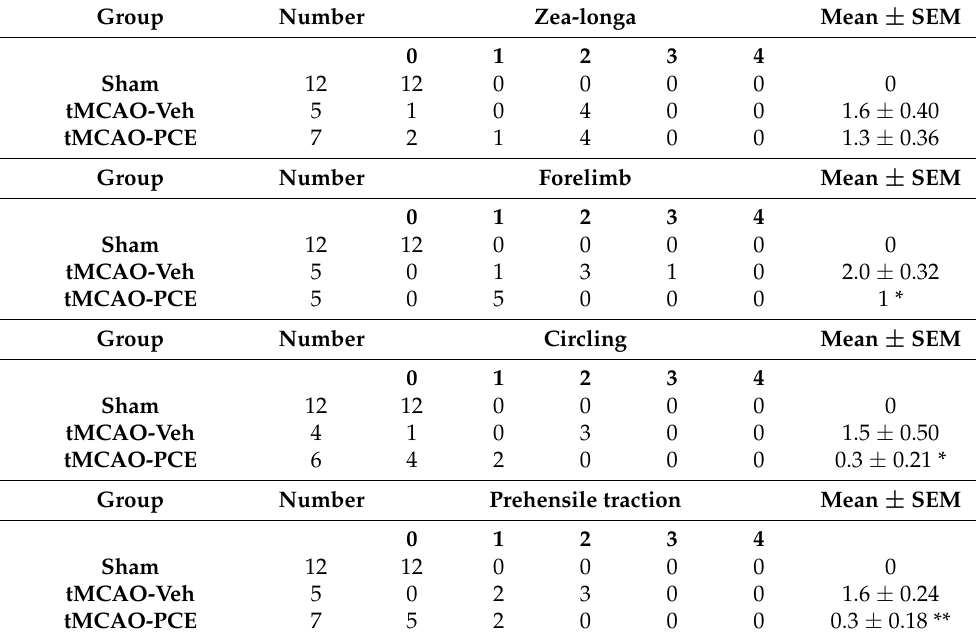
Table 2. Neurological severity score (NSS) changes after PCE treatment in ischemic stroke mouse model. Evaluation of neurological deficits using four test parameters 1 day after ischemic stroke. The scores of the mice are marked according to the scales used. Values are mean ± SEM. ** p < 0.01, * p < 0.05, compared with the vehicle-treated tMCAO group, determined by Student’s t